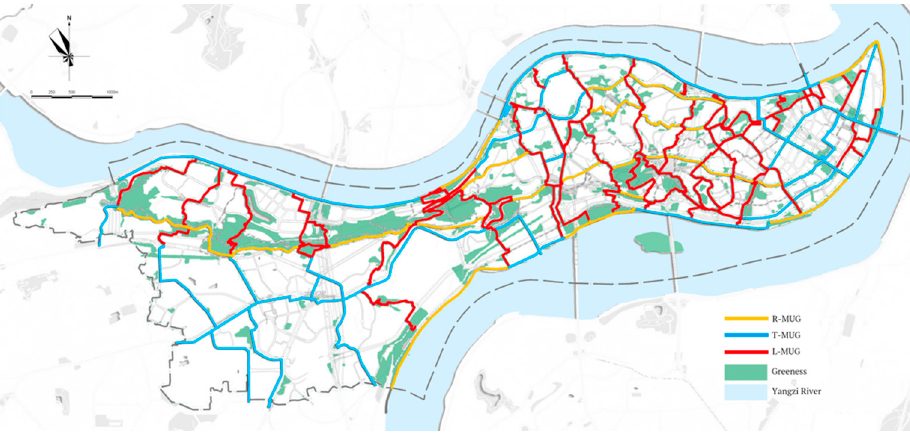
Figure 2. Yuzhong Peninsula MUGs. Source: Chongqing City Bureau of Urban Planning.